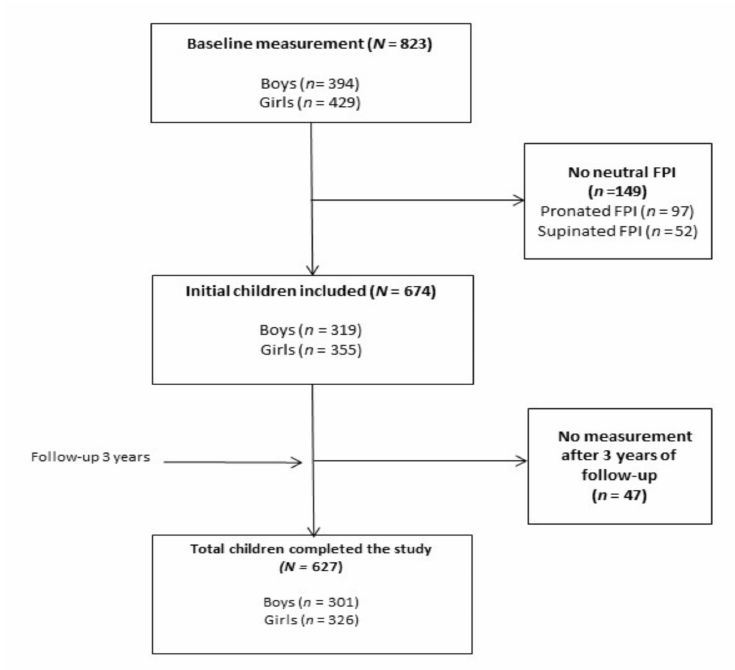
Figure 1. Participant selection